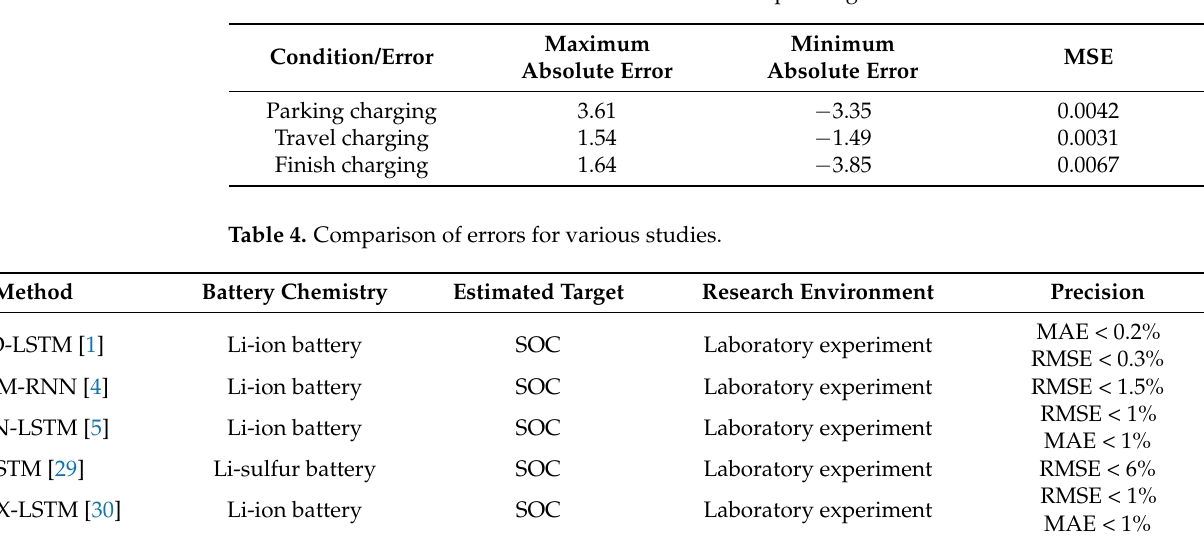
Table 3. SOC estimation result error in three different operating conditions.